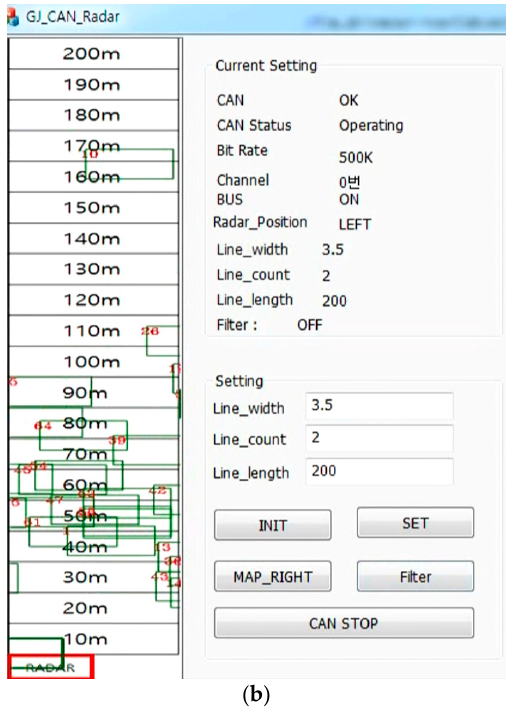
Figure 12. Radar installation in tunnel: ( a ) Vehicle in tunnel; ( b ) measured data.